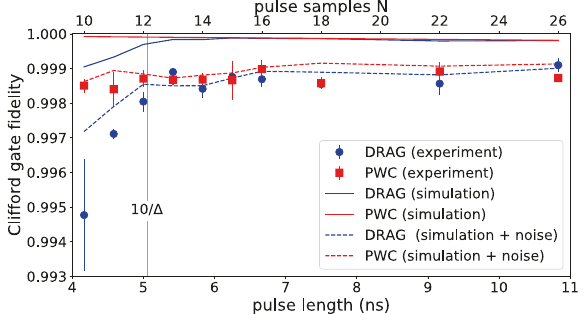
Fig. 3 Pulse fi delities for different pulse-lengths. The fi delity is measured with RB as a function of pulse length for optimized DRAG (blue circles) and piecewise-constant (PWC) pulses (red squares). Simulated fi delities are shown as lines (see Methods and Supple- mentary Notes 1 and 3). The simulated PWC fi delities (red solid line) reach the T 1 coherence limit.